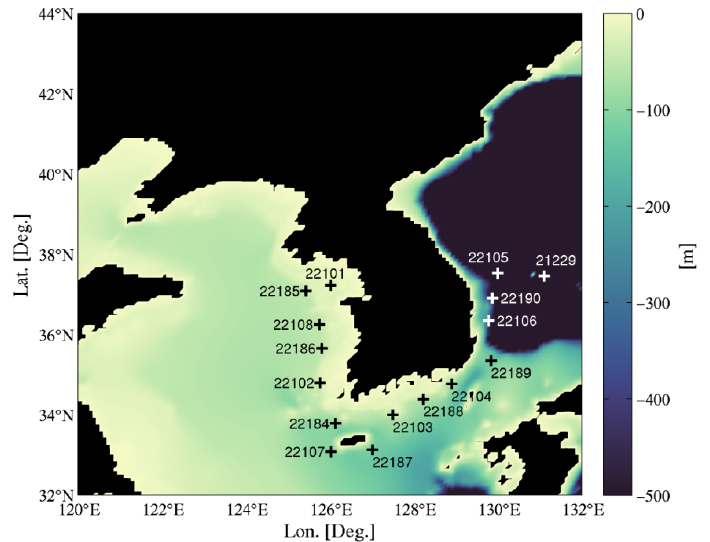
Figure 1. Numerical domain and topography for the rapid refresh wave forecast model (+ indicates the ocean data buoys). the ocean data